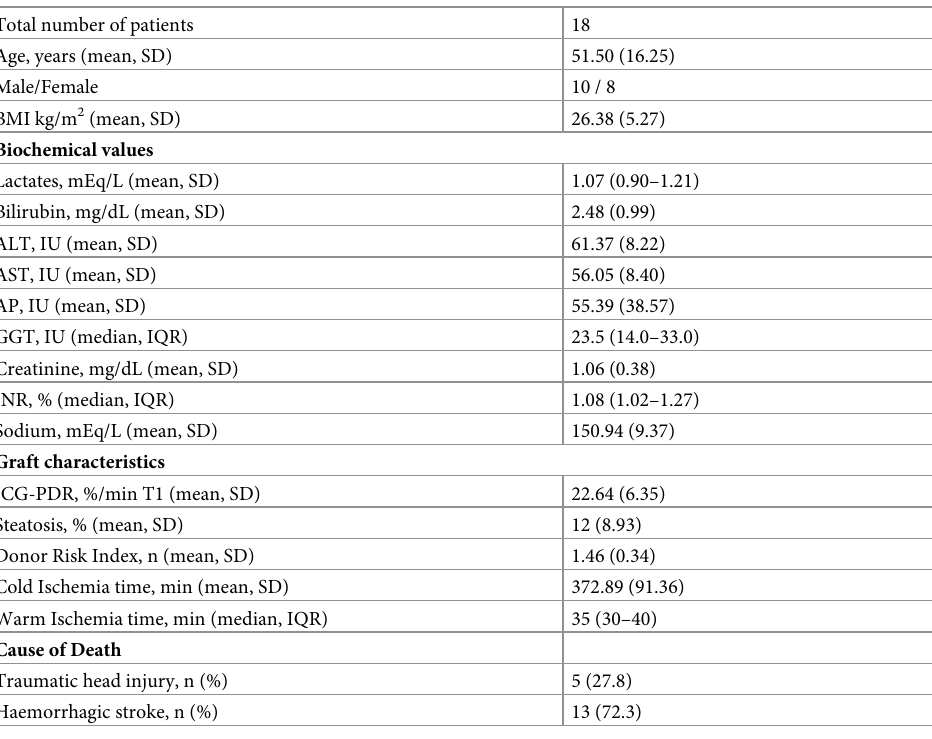
Table 1. Donor demographical and laboratory